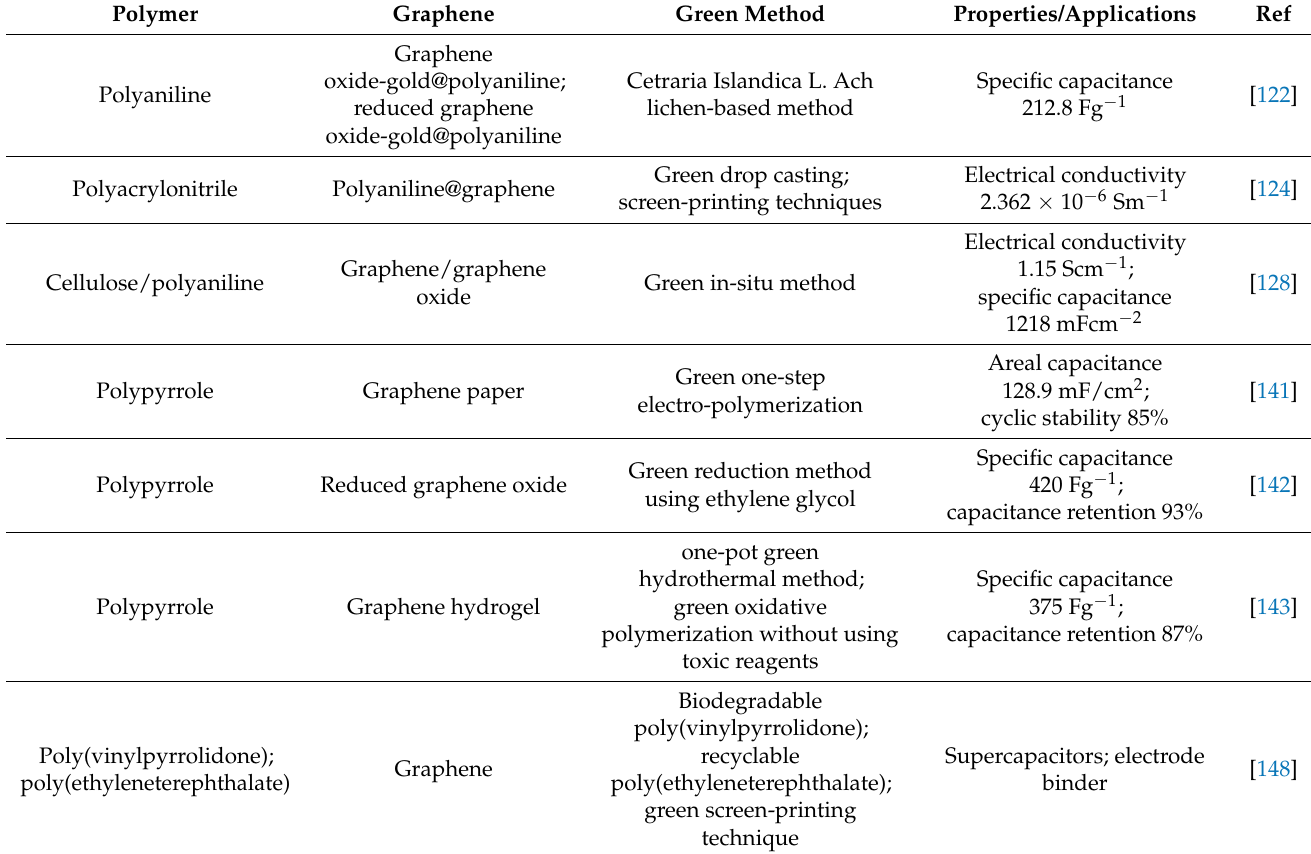
Table 1. Specifications of green synthesized